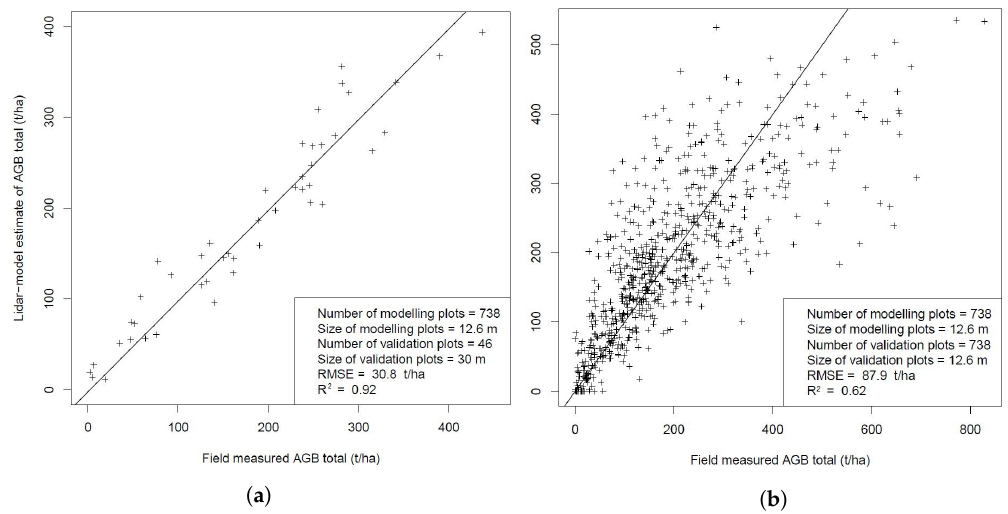
Figure 9. Scale-dependency of validation results for 12.6 m-plot model: ( a ) Scattergram showing the measured (x-axis) and estimated (y-axis) AGB of 30 m-plots; ( b ) Scattergram the measured (x-axis) and estimated (y-axis) AGB of 12.6 m -plots (leave-one-out validation). Table 12. Error statistics for the LiDAR model built from 738,12.6 m-plots. The model predictions of AGB were validated against field data from 30 m